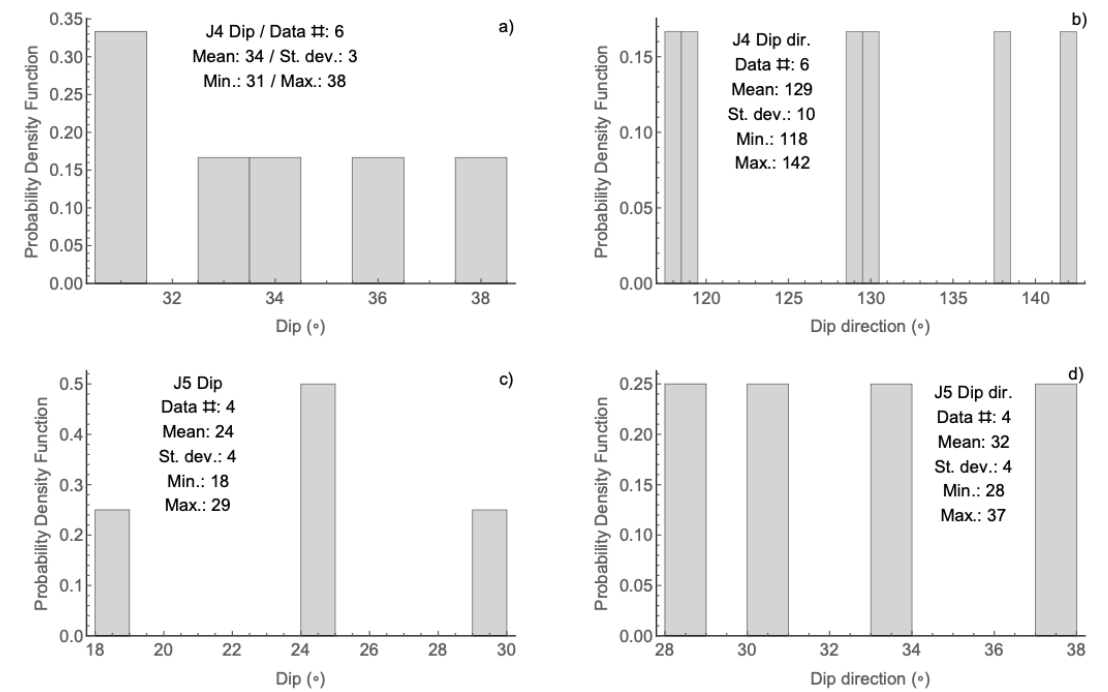
Figure 10. Probability density histograms of joint set orientation. J4 dip ( a ) and dip direction ( b ), J5 dip ( c ), and dip direction ( d ). Appl. Sci. 2020 , 10 , x FOR PEER REVIEW